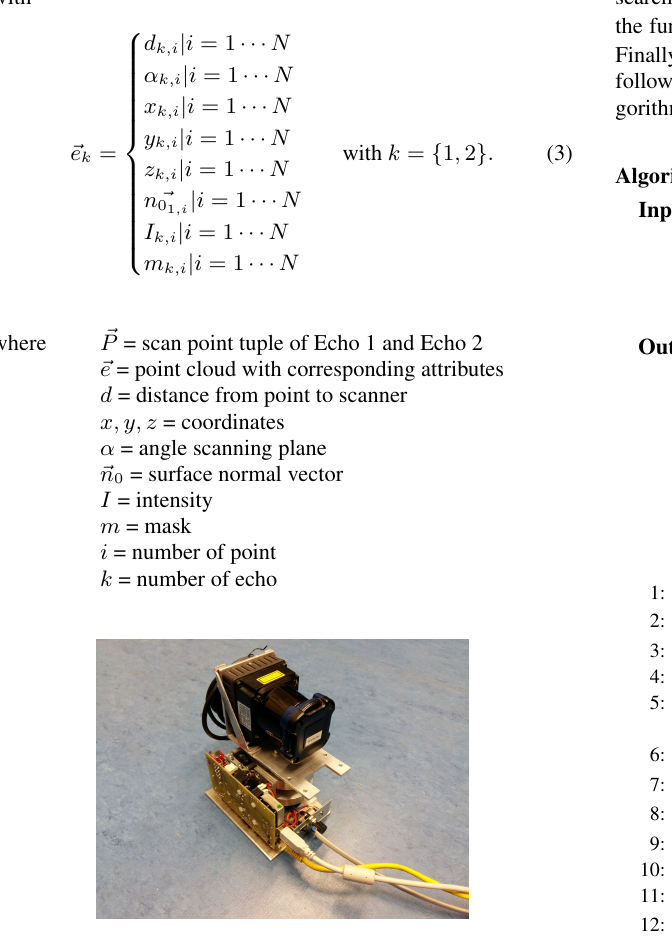
Figure 2: Rotating Hokuyo UTM-30LX-EW multi-echo laser.